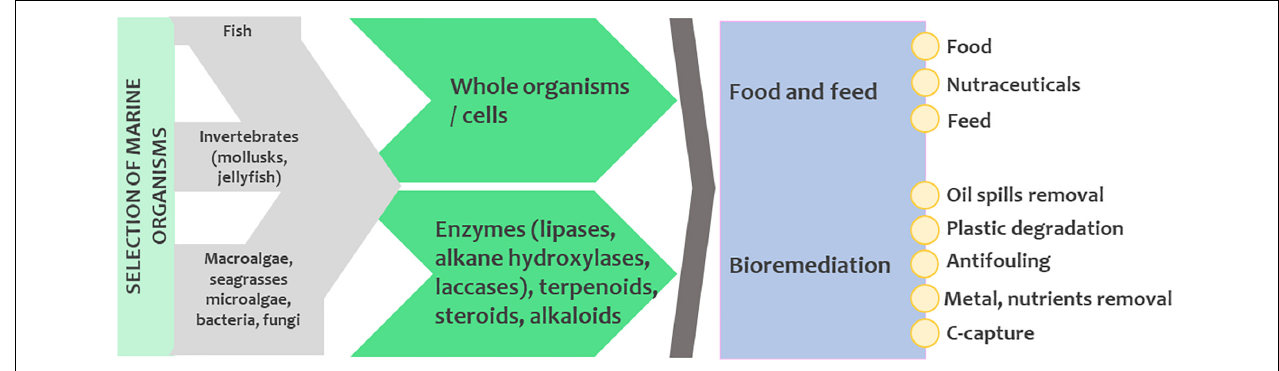
FIGURE 5 | The potential for using marine organisms in food and feed industries and for bioremediation